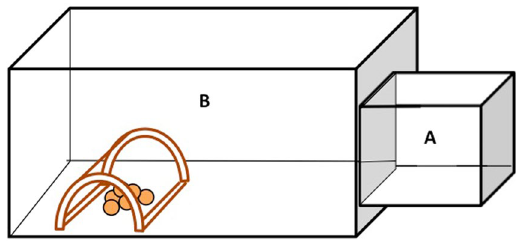
Figure 2. Side view of the experimental apparatus used to assess impulsiveness. The bird was first confined during 20 seconds in the observation chamber ( A ) then, it could enter the experimental chamber ( B ) where 5 millet seeds were placed inside either a transparent or an opaque